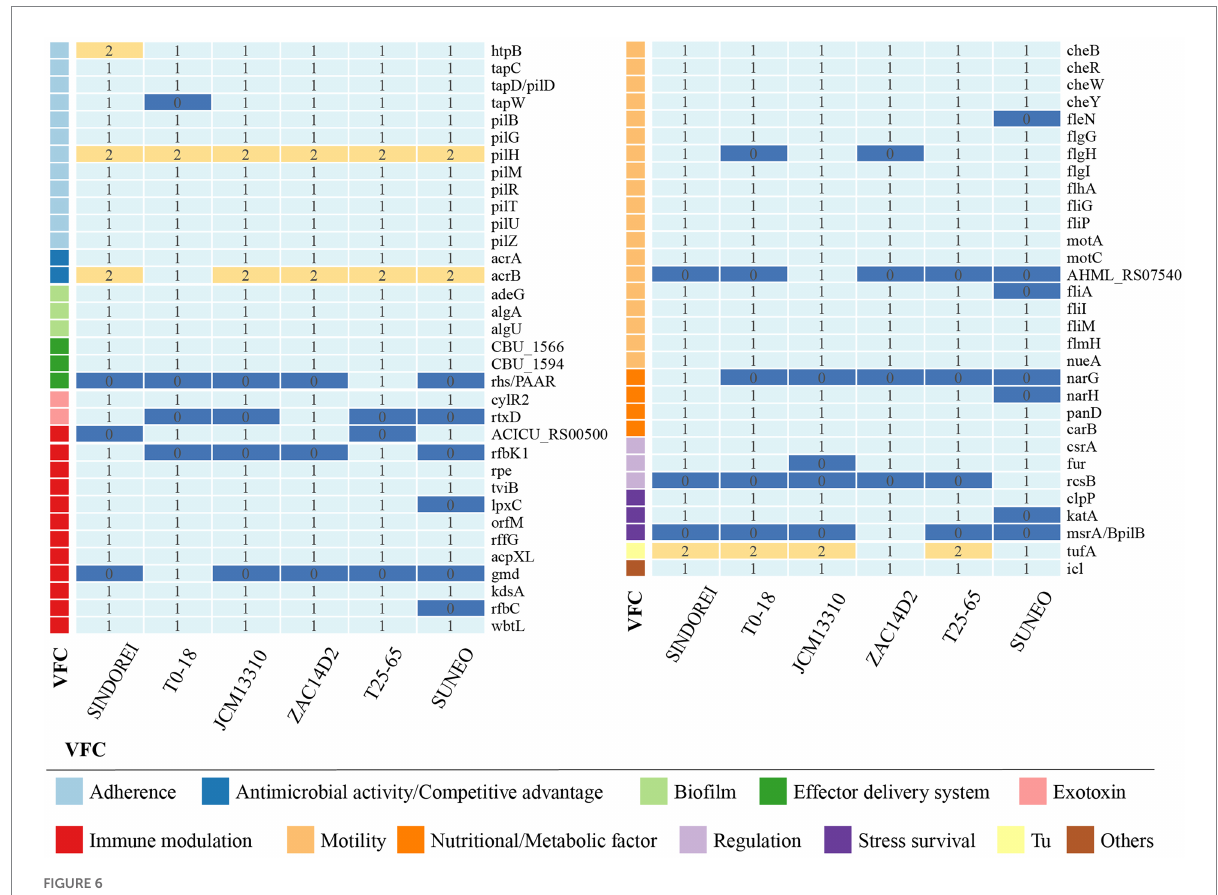
FIGURE 6 Comparison of the virulence factor genes in Stenotrophomonas acidaminiphila. The numbers show the gene copies in each genome and the virulence factor genes were classified into